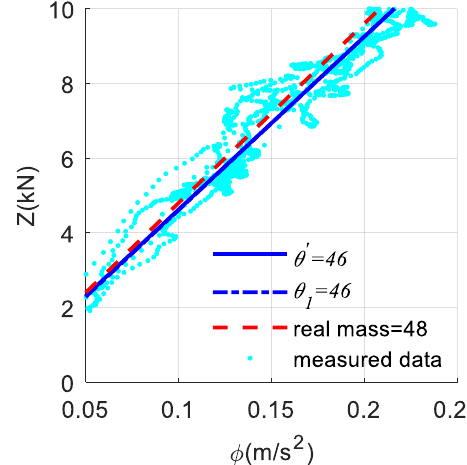
Figure 9. Total valid input and output of the offline estimation in one independent test (full load 1).